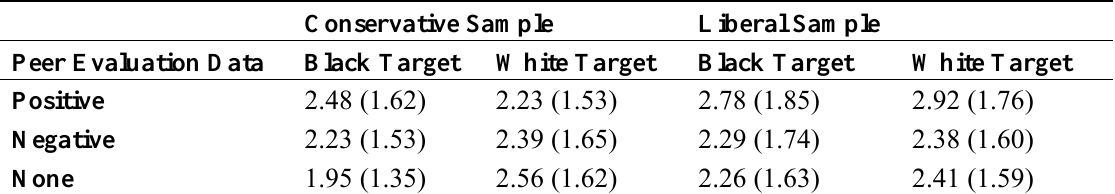
Table 2. Mean dating interest ratings by type of peer evaluation data, target race, and